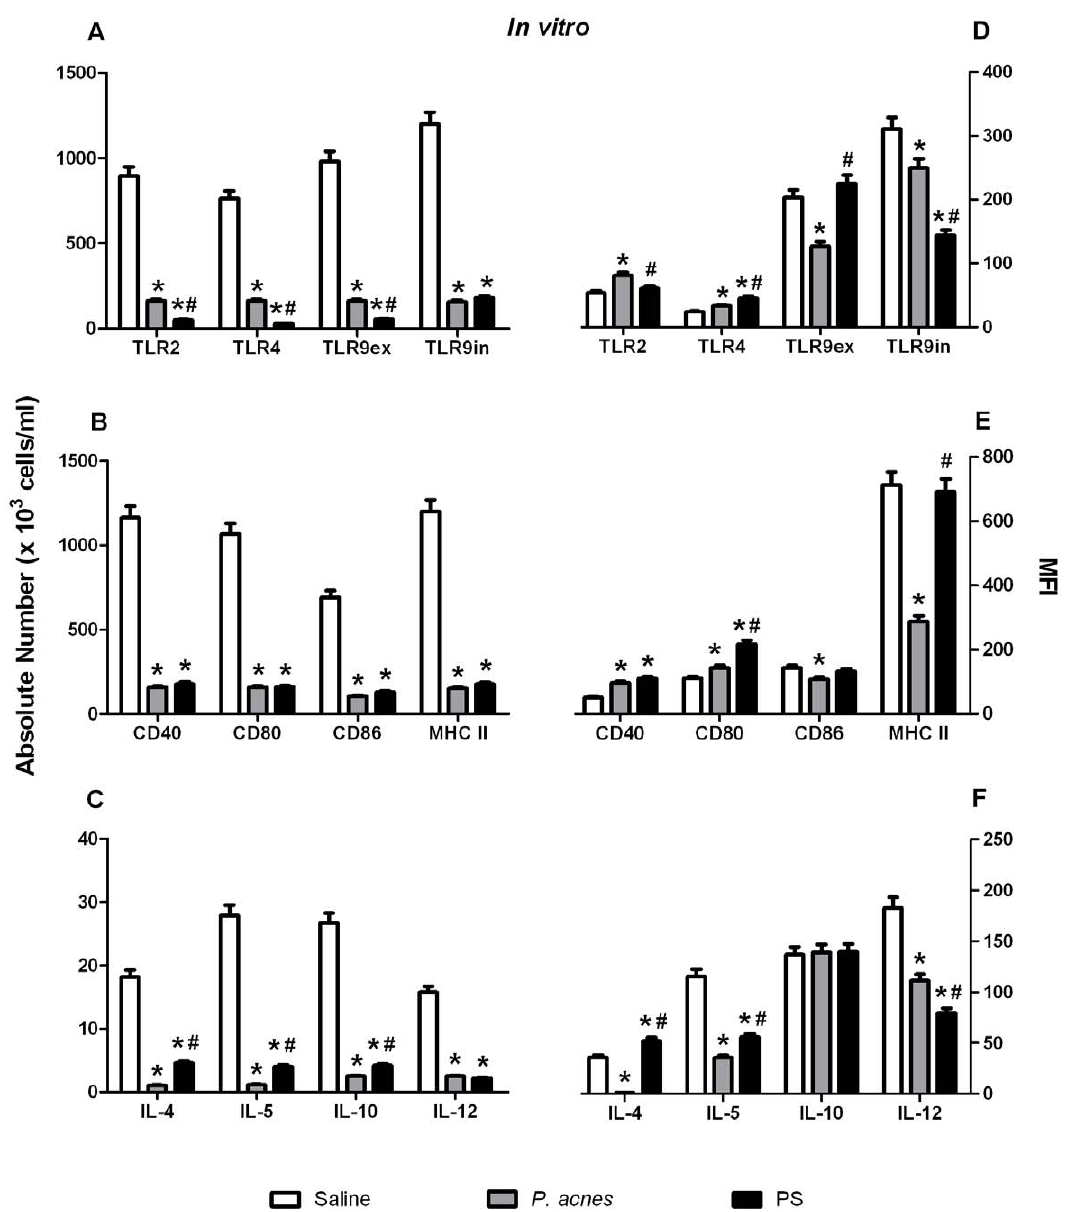
Figure 3. Analysis of the activation status of B-1b lymphocytes invitro . The non-adherent cell population that was obtained after 5 days in a B-1b enriched culture obtained from P. acnes -, PS-, or saline- (control group) treated mice was analyzed to determine TLR, co-stimulatory molecule, MHC II and cytokine expression in B-1b lymphocytes. The cells were stained with mAbs to identify the absolute numbers (A to C) of B-1b lymphocytes that expressed each molecule and the mean fluorescence intensity (MFI) of each marker (D to F). The absolute cell number and MFI are the means of two independent experiments with similar results. * p , 0.05 between the control and treated groups. # p , 0.05 between the P. acnes and PS treated